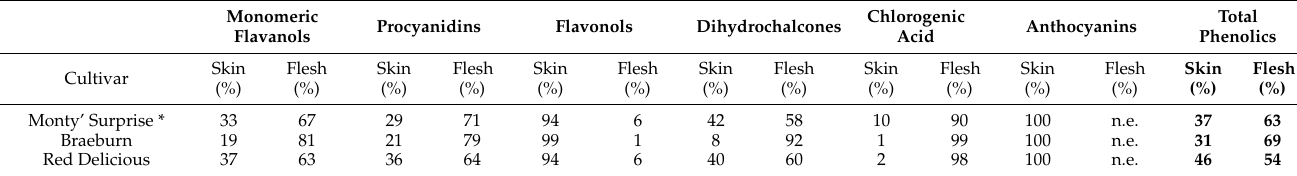
Table 2. Estimated apple peel contribution to the total phenolics content in whole apple. Phenolic compounds were measured using liquid chromatography-mass spectrometry (LC-MS, Dionex Ultimate RS3000 UHPL and a Bruker micrOTOF- QII) in 2019, plant and food research, for 3 apple varieties—Monty’s surprise, Braeburn, and Red Delicious. Each compound concentration was quantified by comparison with an authentic standard where possible or as equivalents to standard compounds. Each phenolic compound in the table is presented as a percentage of total concentration measured using LC-MS. Percentage total phenolics (percentage values presented in bold) was calculated based on the average weight of whole apple (180 g) where apple skin contributed 18